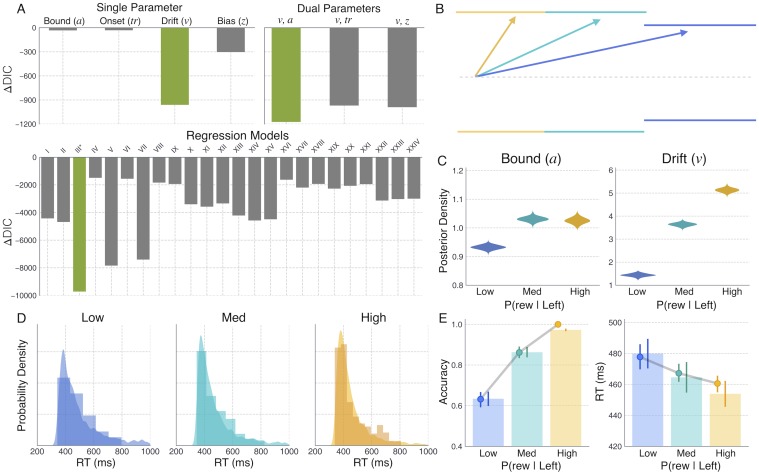
DDM fits to CBGT-simulated behavior reveals pathway-specific effects on drift rate and threshold mechanisms.A: ΔDIC scores, showing the relative goodness-of-fit of all single- and dual-parameter DDMs considered (top) and all DDM regression models considered (bottom) compared to that of the null model (all parameters held constant across conditions; see Table 2). The ΔDIC score of the best-fitting model at each stage is plotted in green. The best overall fit was provided by DDM regression model III. B: DDM schematic showing the change in v and a across low (blue), medium (cyan), and high (yellow) reward conditions, with the threshold for L and R represented as the upper and lower boundaries, respectively. C: Posterior distributions in each reward condition for a (Eq 1), estimated on each trial as a function of the average iMSN firing rate across left and right action channels (see Iall in Fig 4C), and v (Eq 2), estimated on each trial as a function of the the difference between dMSN firing rates in the left and right channels (DL − DR in Fig 4B). D: Histograms and kernel density estimates showing the CBGT-simulated and DDM-predicted RT distributions, respectively. E: Point plots showing the CBGT network’s average accuracy and RT across reward conditions overlaid on bars showing the DDM-predicted averages.